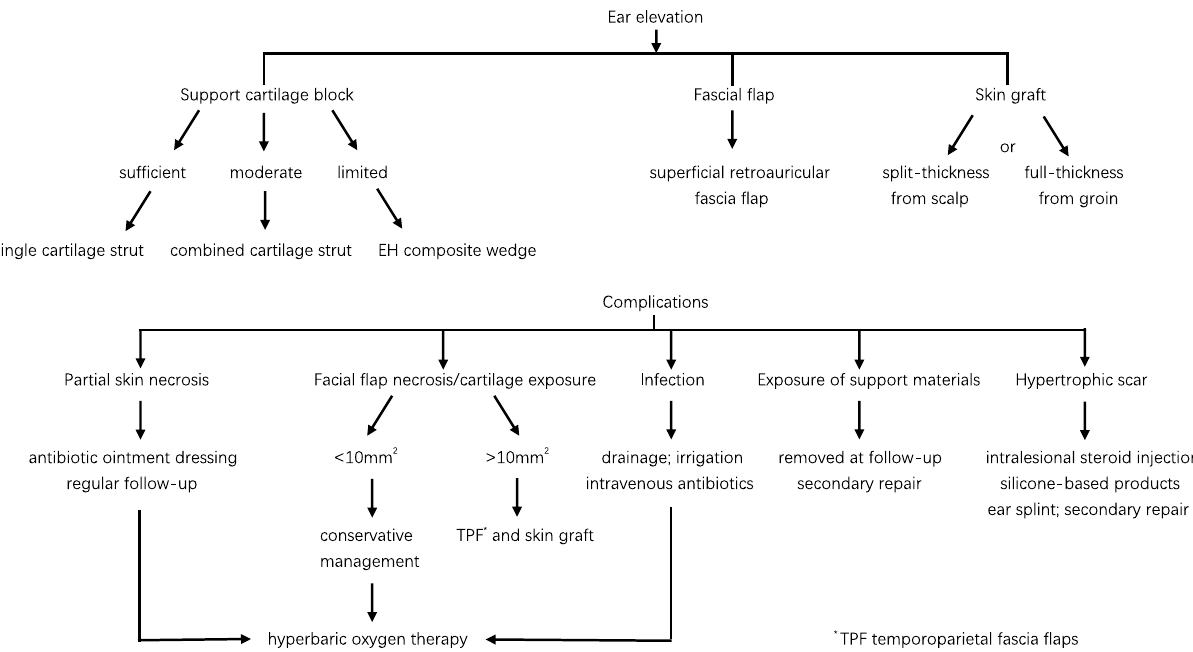
Table 3. The algorithm of ear elevation and the treatment of relevant complications. TPF temporoparietal fascia flaps.